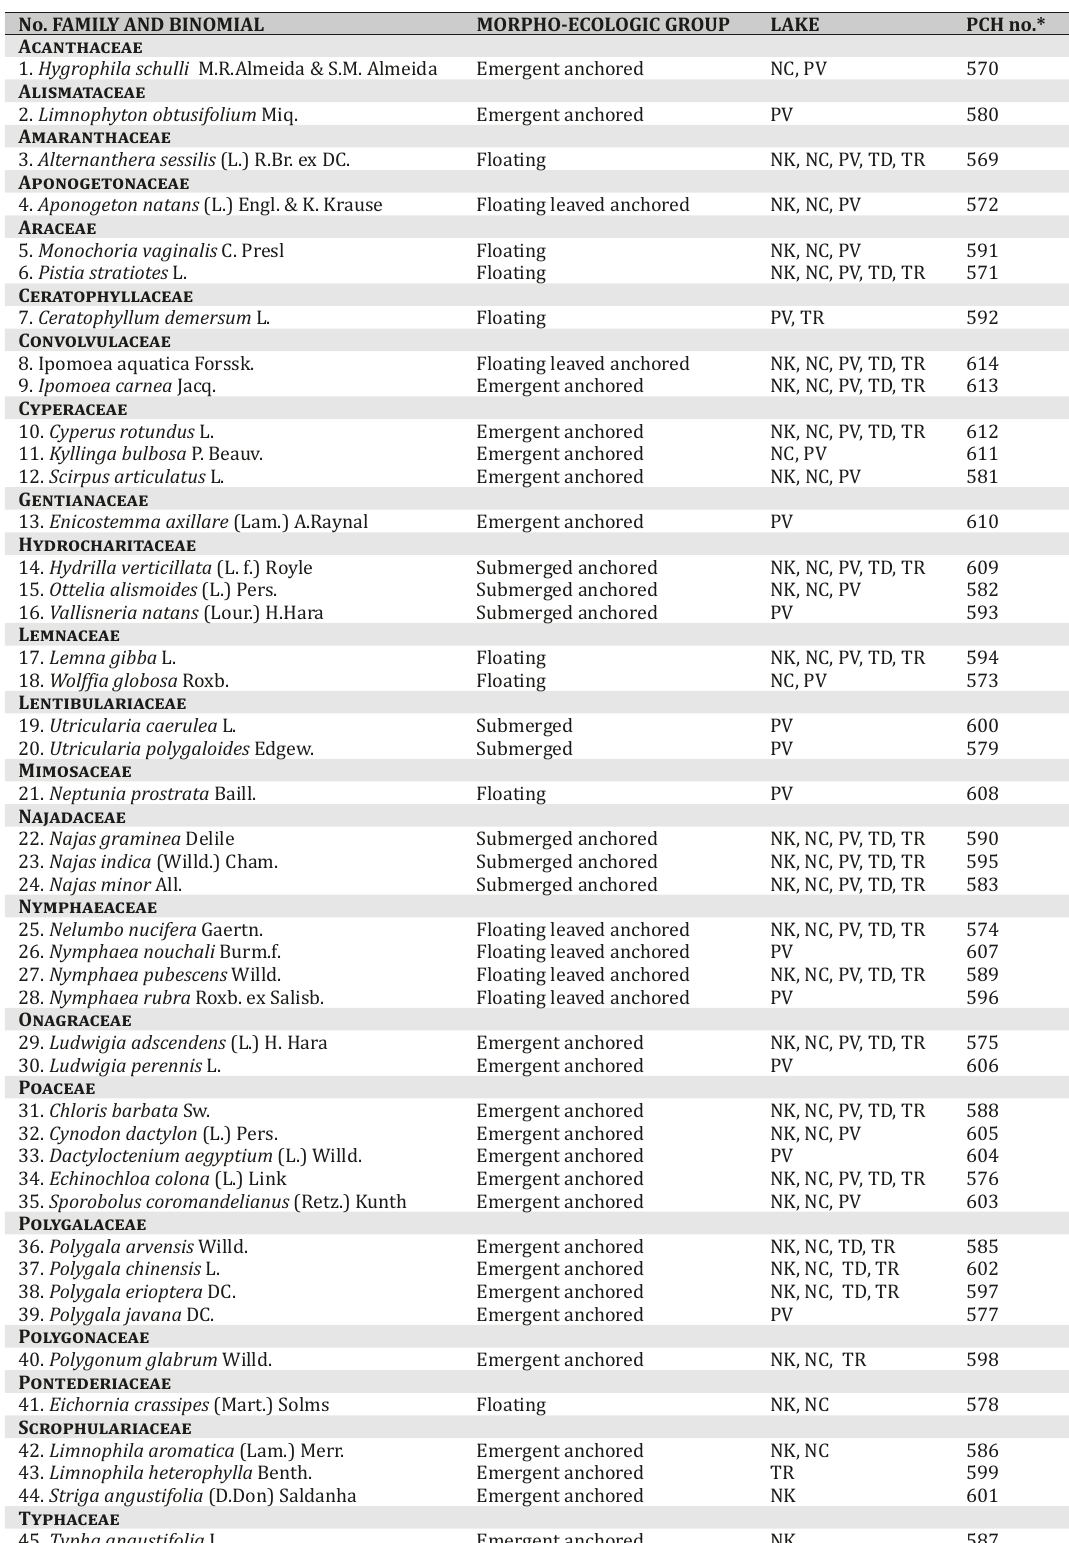
Table 1. List of hydrophytes, encountered during 2005-2007 from five ephemeral lakes Nadukutthagai (NK), Nimilacherry (NC), Palavedu (PV), Thandurai (TD) and Thirunindravur (TR) of Thiruvallur District, Tamil Nadu, India. *Pachaiyappa’s College Herbarium. No. FAMILY AND BINOMIAL MORPHO-ECOLOGIC